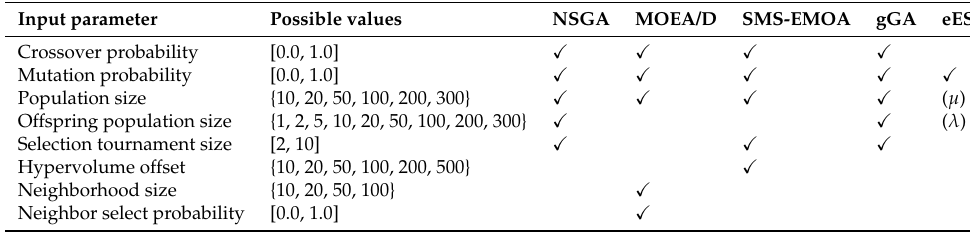
Table 3. Input parameter set for irace auto-configuration.